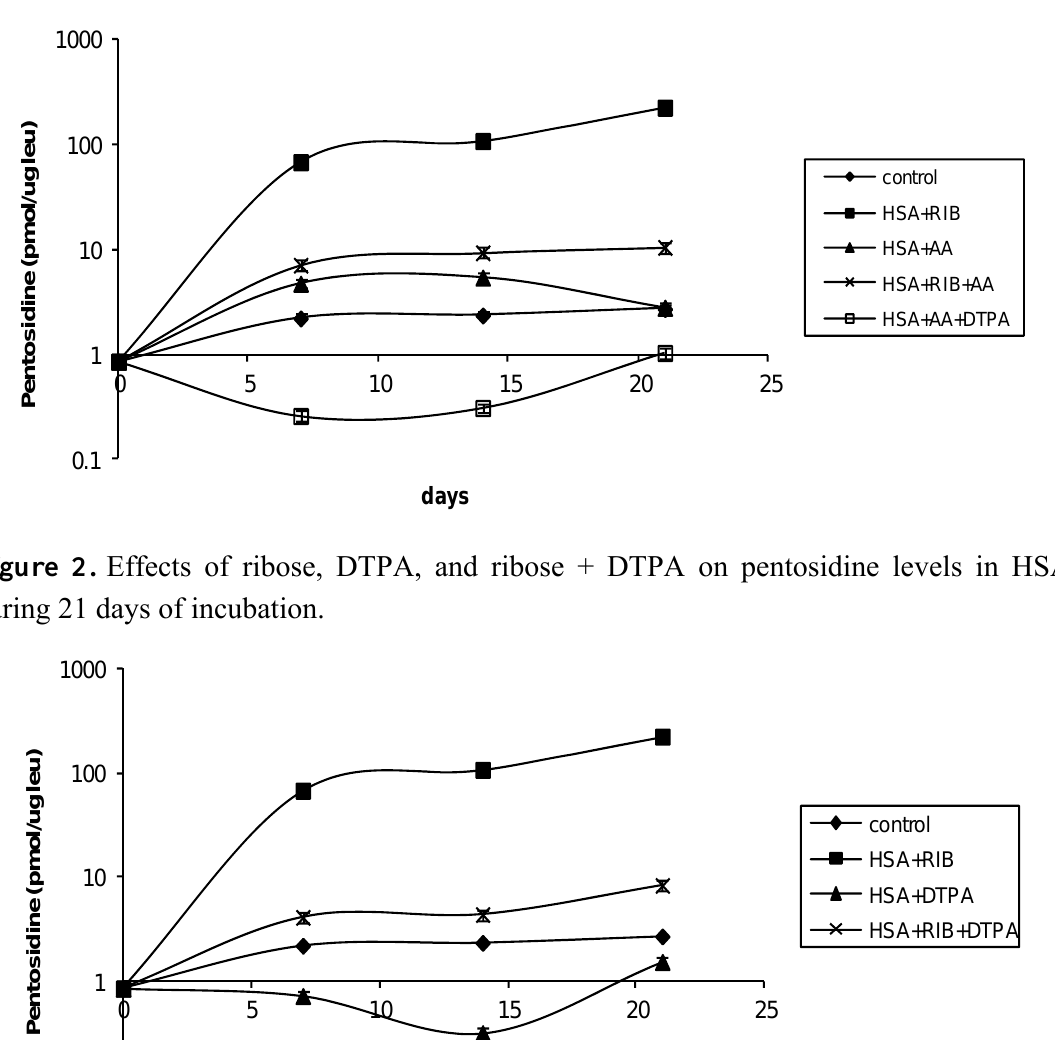
Figure 1. Effects of ribose, AA, AA + ribose, and AA + DTPA on pentosidine levels in HSA during 21 days of incubation.